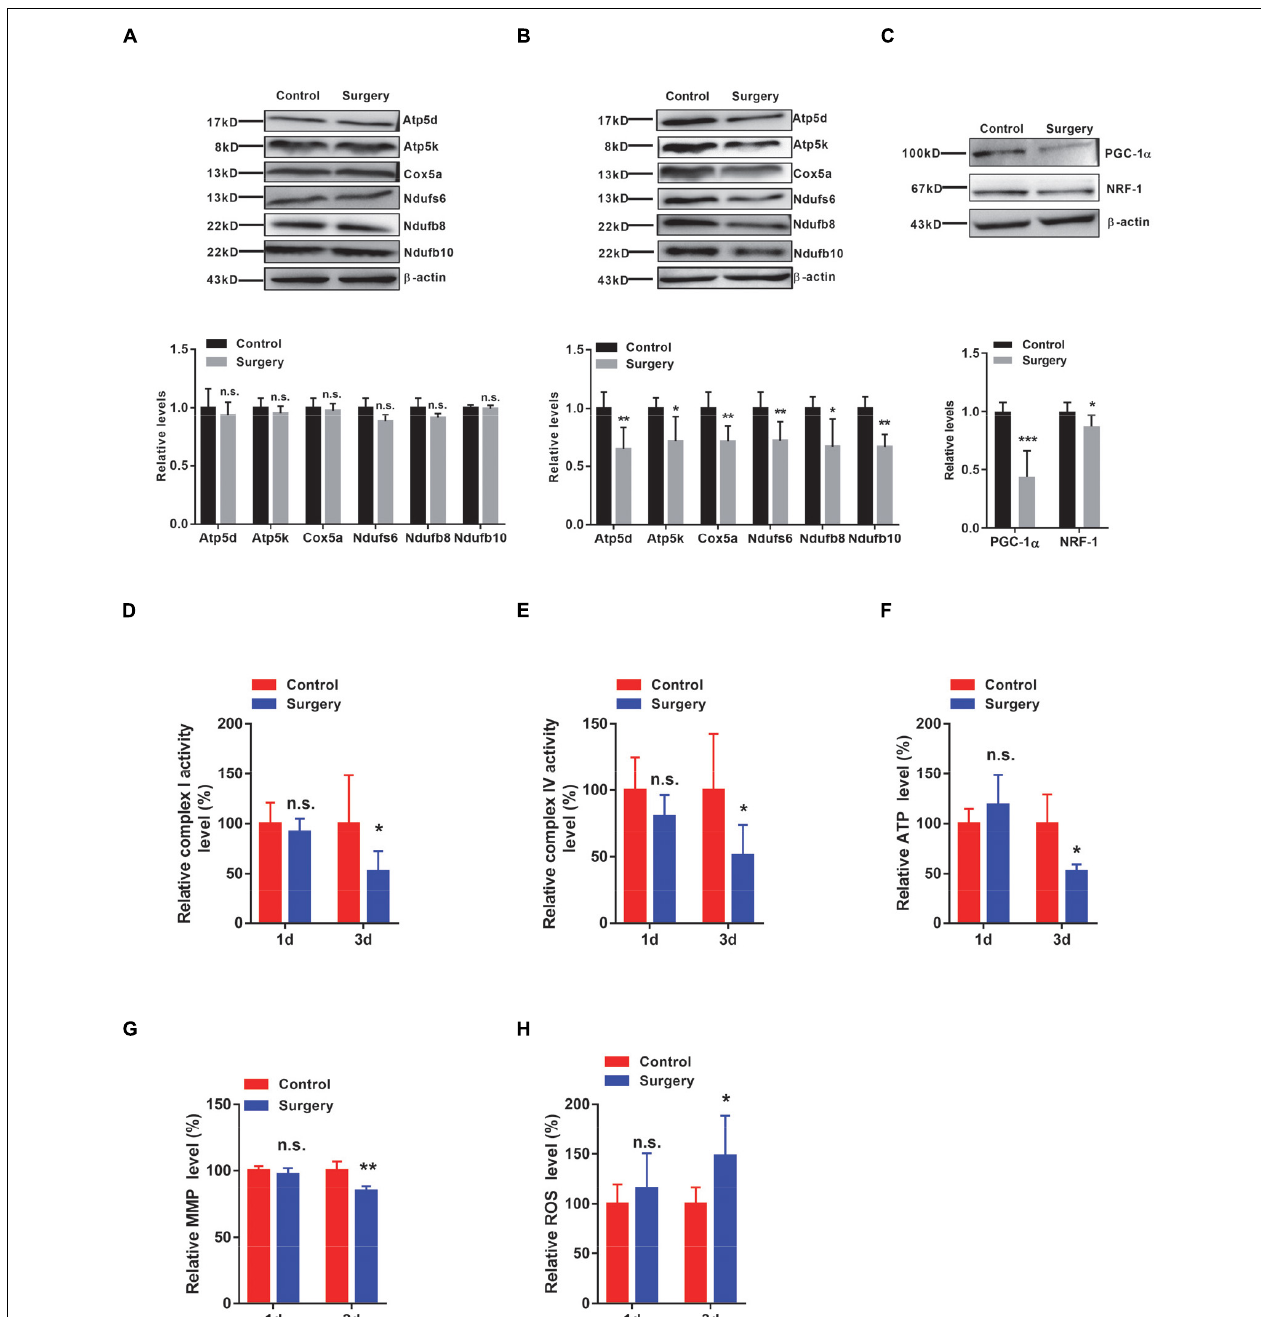
FIGURE 4 | Respiratory complex levels and respiratory function are decreased in the Perioperative neurocognitive disorder (PND) mouse brain by downregulating both peroxisome proliferator-activated receptor- γ coactivator-1 α (PGC-1 α ) and Nuclear respiratory factor-1 (NRF-1) levels. (A,B) Protein levels of Atp5d and Atp5k (complex V); Cox5a (complex IV); and Ndufs6, Ndufb8, and Ndufb10 (complex I) were determined in hippocampal tissues collected from control and surgery mice (1 day post-surgery) ( n = 4) (A) or from control and surgery mice (3 days post-surgery) ( n = 5) (B) , by immunoblotting and densiometric analysis. (C) Levels of PGC-1 α and NRF-1 in the hippocampal tissues of control and surgery mice (1 day post-surgery) were determined by immunoblotting and densiometric analysis ( n = 6). β -actin was included as an input control. (D,E) Hippocampal tissues were isolated from control or surgery mice (1 day or 3 days post-surgery). Enzymatic activities of NADH dehydrogenase (complex I) (D) and cytochrome C oxidase (complex IV) (E) were assessed by an ELISA-based approach ( n = 8 per group). (F–H) Hippocampal tissues were isolated from control or surgery mice (1 day or 3 days post-surgery) ( n = 5 per group). (F) Adenosine triphosphate (ATP) levels were assessed by an ELISA-based analysis. (G) Mitochondrial membrane potential (MMP) levels were determined by the JC-1 fluorescence probe-based approach. (H) Relative reactive oxygen species (ROS) levels were determined by the DCFHDA probe-based approach. * P < 0.05; ** P < 0.01; *** P < 0.001 by independent samples Student’s t -test; n.s. not significant; error bars denote the